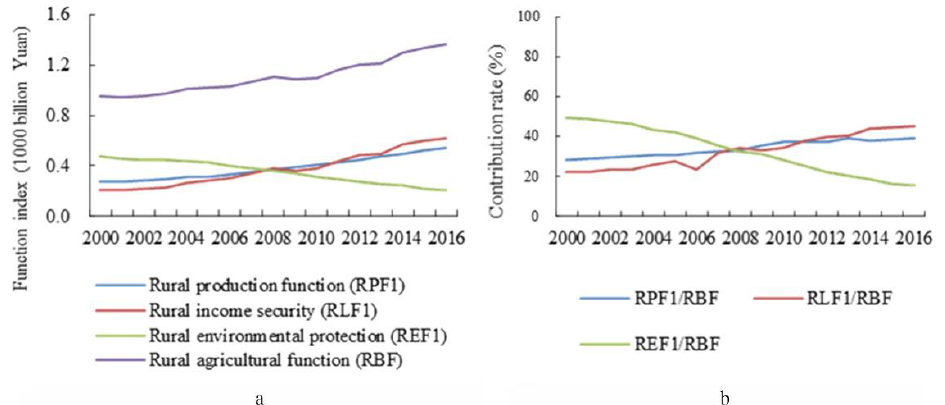
Figure 6. Index and contribution rate changes of rural comprehensive and production, living and ecological function in Jianghan Plain from 2000 to 2016. ( a ) indexes of rural agricultural function and sub-function, ( b ) contribution rates of the sub-function of rural agricultural function